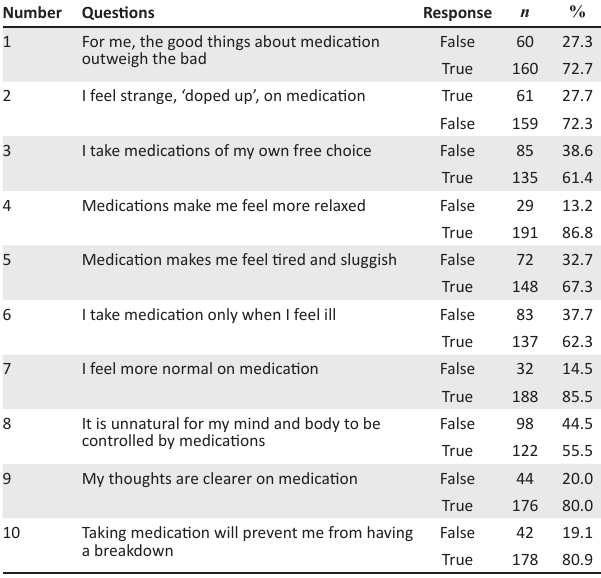
TABLE 1: Mean scale score and frequency of Drug Attitude Inventory item scale of respondents ( n = 220). Number Questions